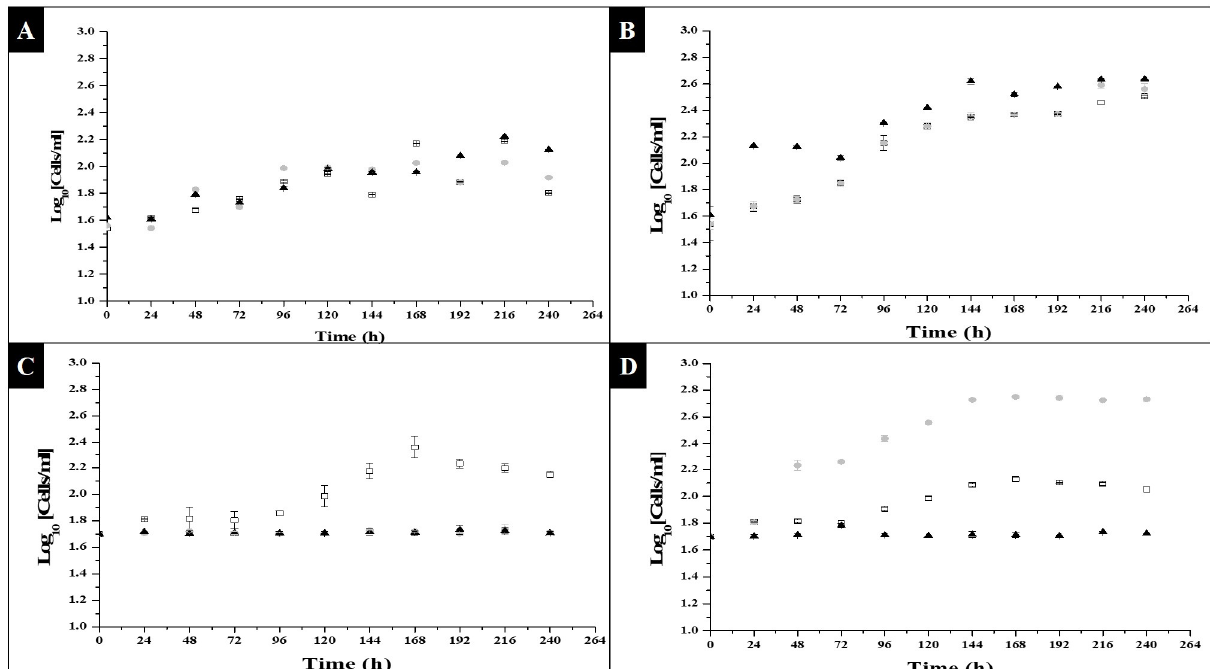
Figure 1. Cell growth of C. vulgaris under photoheterotrophic medium: ( A ) sodium acetate in 8 light hours and 16 darkness photoperiods; ( B ) sodium acetate in 16 light hours and 8 darkness photoperi- ods. (cid:3) 0.0005 g/L, • 0.001 g/L and (cid:78) 0.0015 g/L sodium acetate concentration; ( C ) glycerol in 8 light hours and 16 darkness photoperiods; ( D ) glycerol in 16 light hours and 8 darkness photoperiods. (cid:3) 0.27 g/L, • 0.33 g/L and (cid:78) 0.44 g/L glycerol